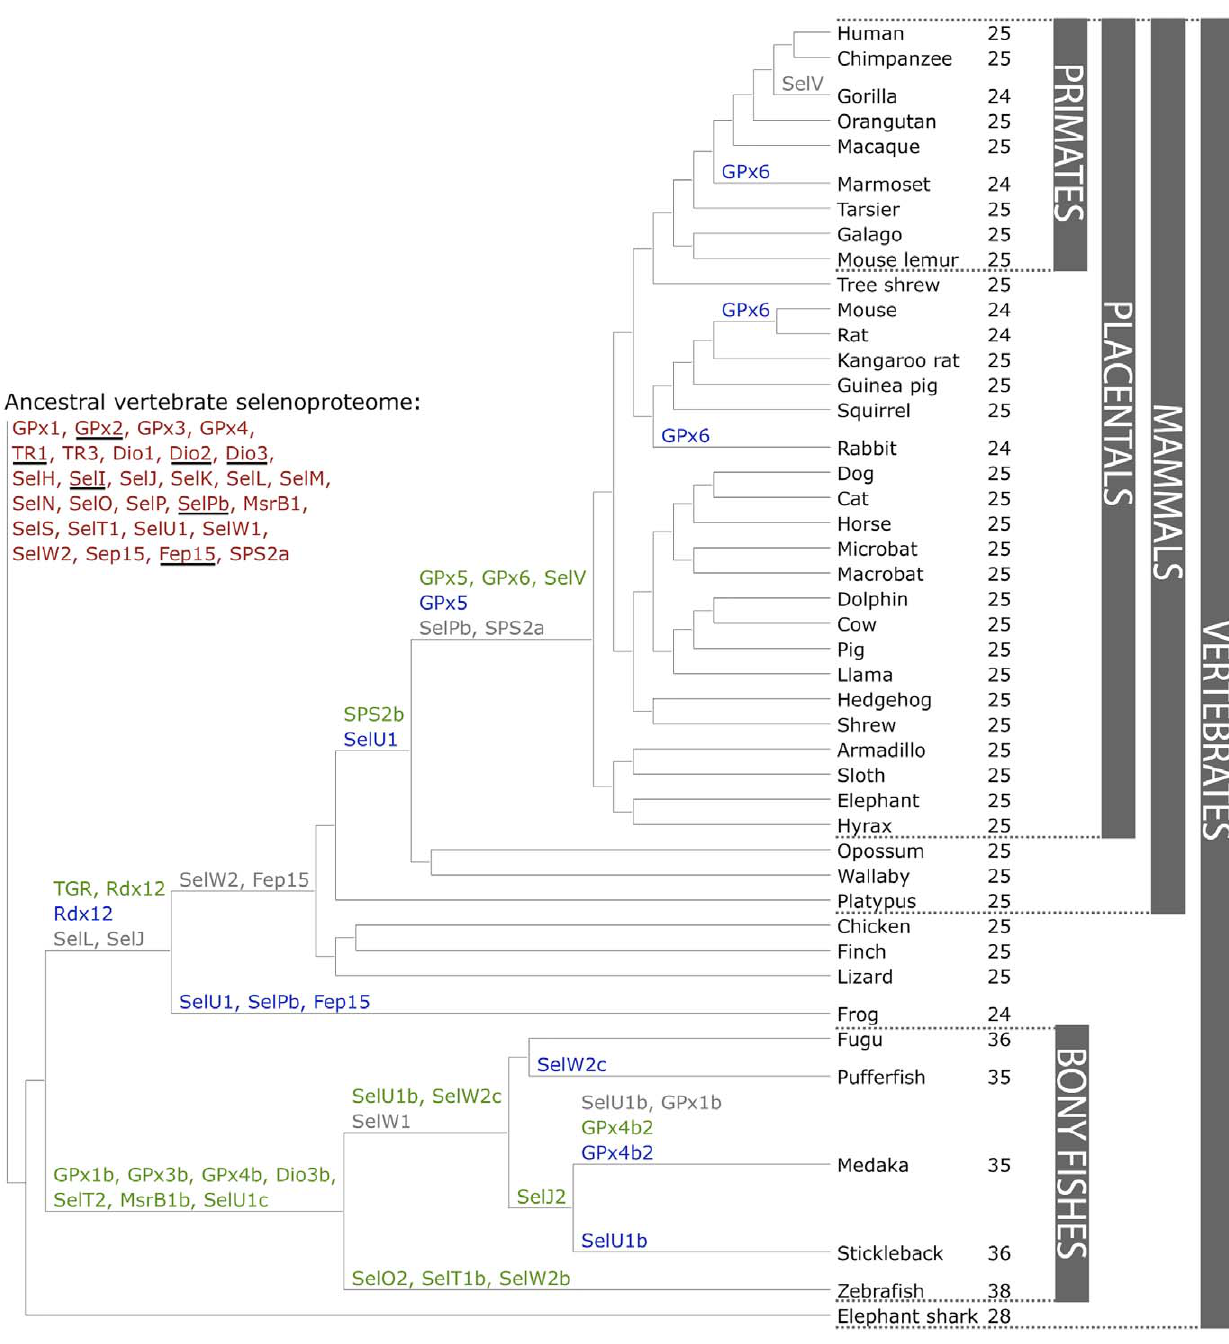
Figure 1. Evolution of the vertebrate selenoproteome. The ancestral vertebrate selenoproteome is indicated in red, and its changes across the investigated vertebrates are depicted along their phylogenetic tree. The ancestral selenoproteins found uniquely in vertebrates are underlined. The creation of a new selenoprotein (here always by duplication of an existing one) is indicated by its name in green. Loss is indicated in grey. Replacement of Sec with Cys is indicated in blue (apart from SelW2c in pufferfish, which is with arginine). Events of conversion of Cys to Sec were not found. On the right, the number of selenoproteins predicted in each species is shown. doi:10.1371/journal.pone.0033066.g001 vertebrates, only SPS2a is present, in placental mammals only comparable in the two versions (596 nucleotides in the single exon SPS2b is present, whereas marsupials still possess both genes version and 555 nucleotides in the multi-exon version). UGA-to- (Figure 2). The protein alignment of SPS2a/b is provided in SECIS distances are also comparable (1805 versus 1542 Supplementary Figure S22. In opossum, both SPS2a and SPS2b nucleotides, respectively). Due to lack of transcription data, we have strong SECIS elements (Supplementary Figure S32), and the cannot be sure that both versions are active. In wallaby (another marsupial), we also detected both SPS2a and SPS2b genes. In this distance between the stop codons and the SECIS element is